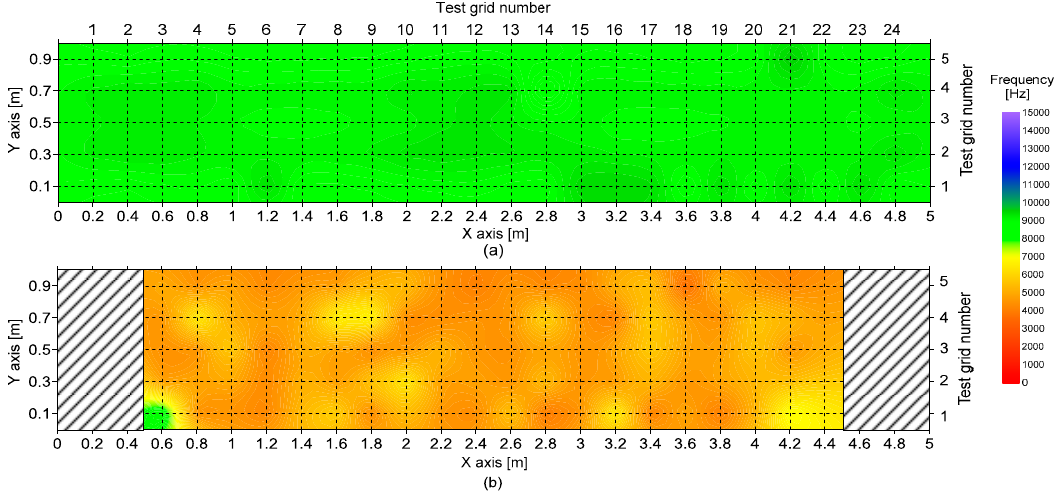
Figure 12. Frequency maps representing the spatial variations in peak frequencies on ( a ) the surface of the sound concrete slab and ( b ) the fire-exposed surface of a concrete slab.